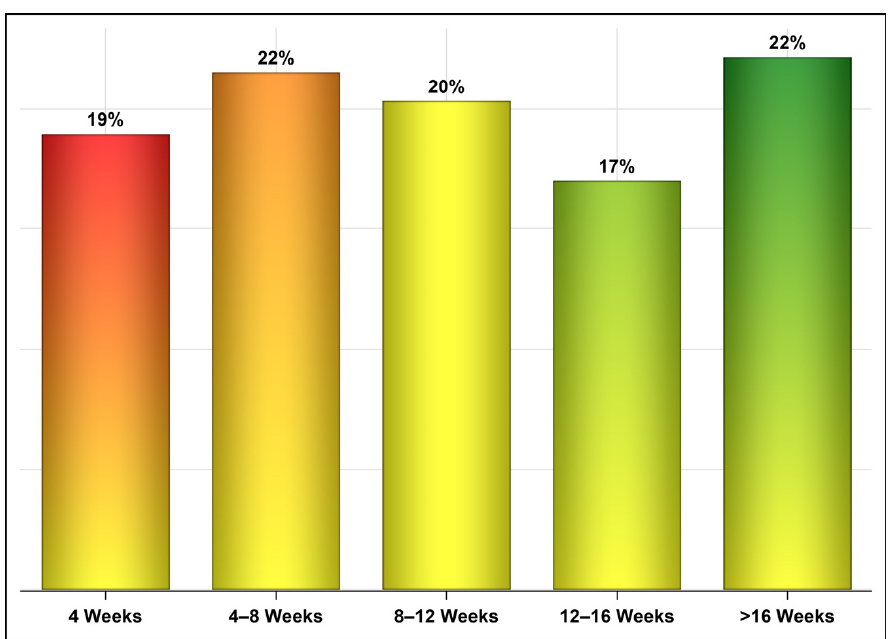
Figure 5. Percentage of patients who were infected with COVID-19 after vaccination across dif- ferent time intervals. The similar percentages of patients who were infected across different time intervals suggest that the time to infection might be related more to the patient characteristics (e.g., medical conditions and sociodemographics) and behavior (e.g., adherence to social distancing and wearing